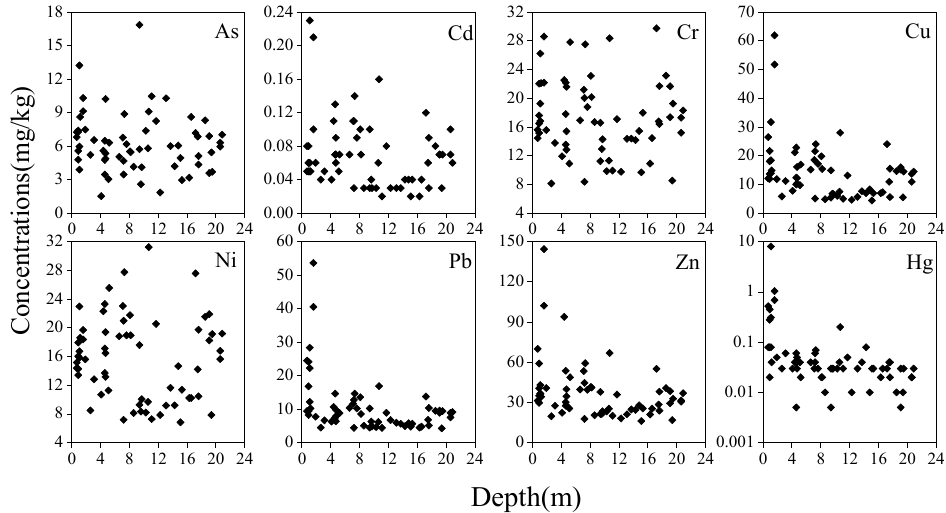
Figure 2. Vertical distributions of the HMs in the soil profile.